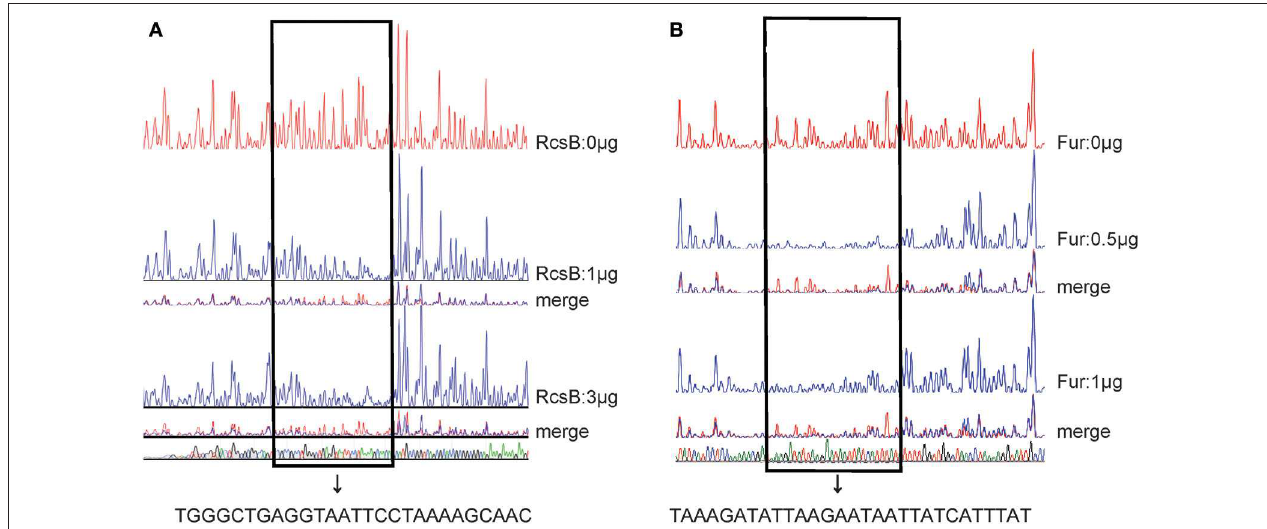
FIGURE 5 | DNase I footprints of RcsAB and Fur at the entC promoter. The promoter DNA regions of entC were labeled with FAM and incubated with increasing amounts of purified His 6 -RcsB (0, 1, 3 µ g) (A) and His 6 -Fur (B) (0, 0.5, 1 µ g). The footprint regions are boxed within lines and marked.